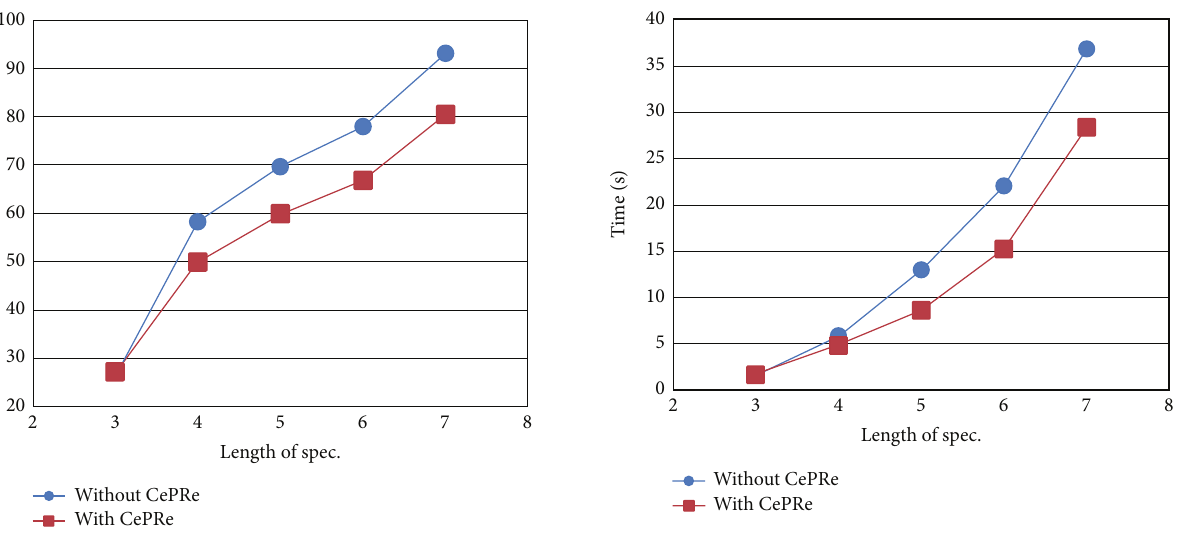
Figure 3: Time overhead in random BDD-MC experiments.